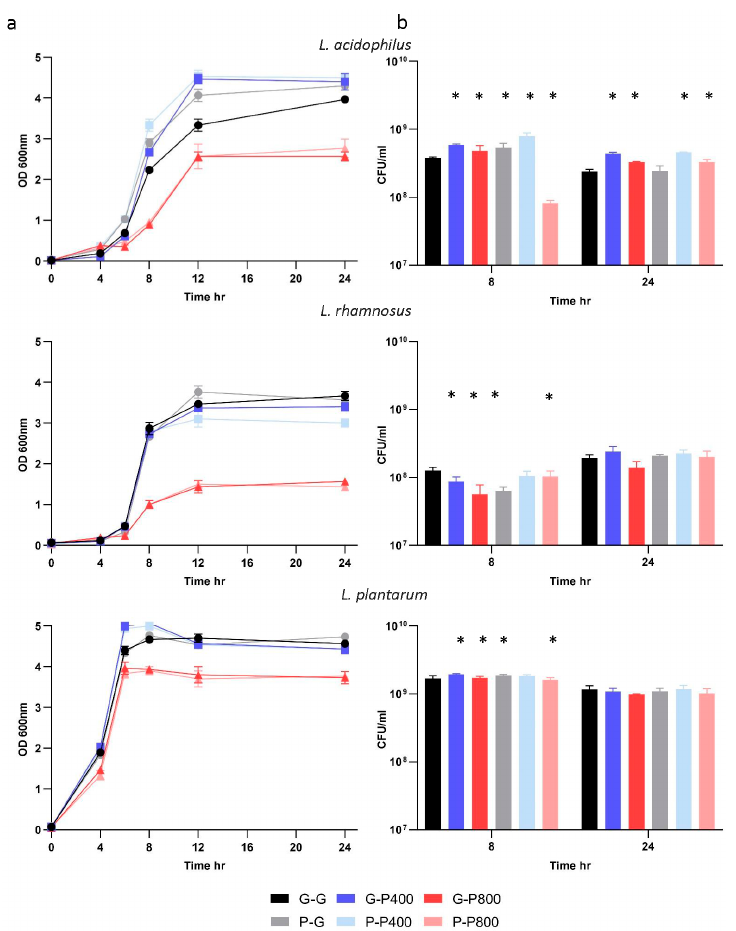
Figure 1. Growth assays of three probiotic strains in the presence of POM extract. ( a ) OD 600 nm values for L. acidophilus , L. rhamnosus and L. plantarum over 24 h at 37 °C. ( b ) CFU/mL counts for each strain at 8 and 24 h. Error bars show the standard deviation of the mean, and * indicates a p value ≤ 0.05 when compared to the control G-G. G-G: transfer in SDM with no POM extract and growth in SDM with no POM extract; G-P400: transfer in SDM with no POM extract and growth in SDM with POM 400 µg/mL extract; G-P800: transfer in SDM with no POM extract and growth in SDM with POM 800 µg/mL extract; P-G: transfer in SDM with POM 400 µg/mL extract and growth in SDM with no POM extract; P-P400: transfer in SDM with POM 400 µg/mL extract and growth in SDM with POM 400 µg/mL extract; P-P800: transfer in SDM with POM 400 µg/mL extract and growth in SDM with POM 800 µg/mL extract.